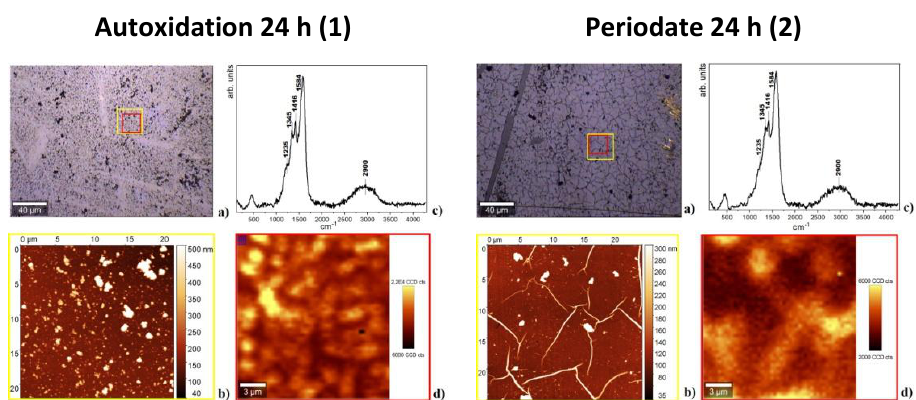
Figure 6. Atomic force microscopy (AFM) and micro-Raman analysis of polydopamine (PDA) films deposited at 24 h following autoxidation (1) and periodate oxidation (2). ( a ) Bright-field image of the investigated sample region collected by 20× microscope objective. ( b ) AFM image of the area indicated by the yellow square in the optical image. Average grain size: 200 nm (1), 150 nm (2). Film thickness: 100 ± 30 nm (1), 55 ± 15 nm (2). ( c ) Raman spectrum. ( d ) Micro-Raman image relative to the red sample region in the optical image.